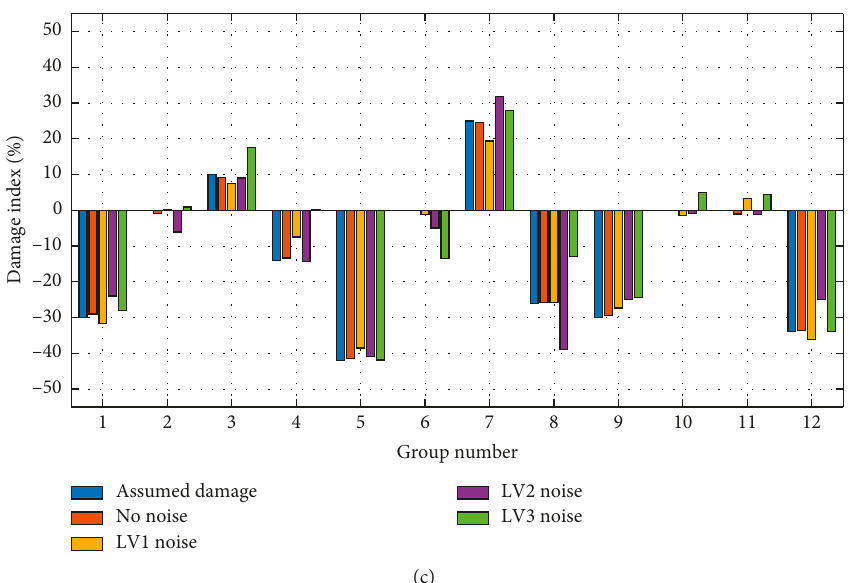
Figure 13: (a) The identified parameters with the first 3 orders of modal shapes and frequencies. (b) The identified parameters with the first 6 orders of modal shapes and frequencies (c) The identified parameters with the first 10 orders of modal shapes and frequencies.